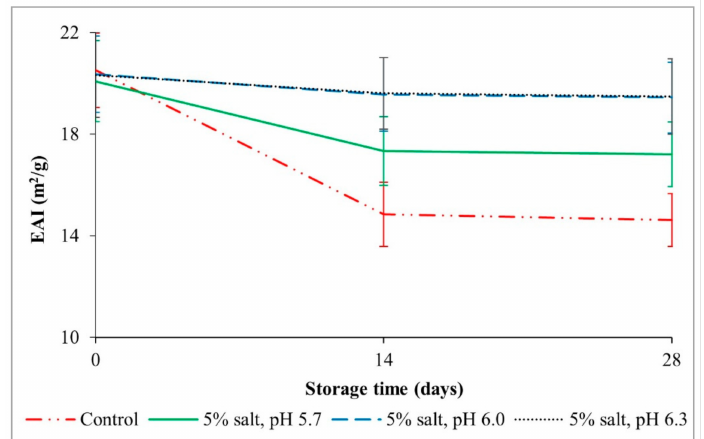
Figure 16. The effect of treatment on the emulsifying activity index (EAI) of frozen-thawed liquid egg yolk. Data are presented with mean ± standard